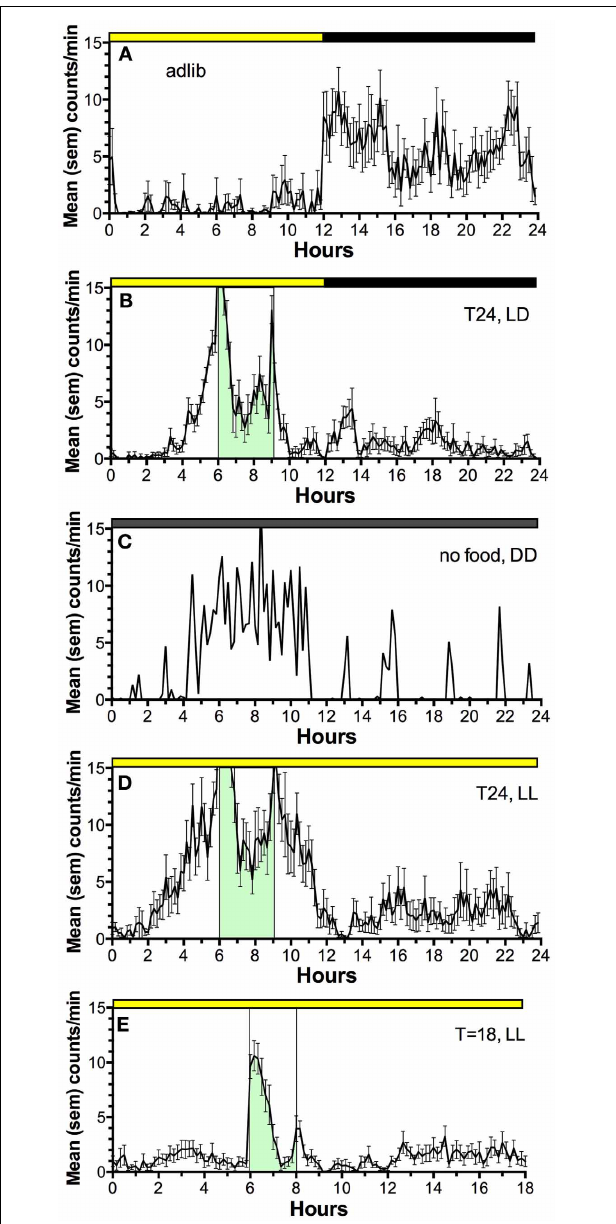
FIGURE 2 | Average waves illustrating the temporal distribution of spontaneous locomotor activity of a representative rat under the following feeding conditions. (A) ad-lib access to food (10 day average). (B) Food restricted to 3-h/day, beginning 6h after lights on, for 3 weeks (last 10 day average). (C) Day 2 of total food deprivation after 3 weeks of restricted daytime feeding. (D) Food restricted to 3-h/day for 3 weeks, after a month in constant light with food ad-lib , to eliminate the light-entrainable, free-running rhythm controlled by the SCN (a reversible SCN “lesion” procedure). (E) Food restricted to 2-h/day in constant light, delivered every 18h, illustrating failure of rats to anticipate a daily meal at regular but non-circadian intervals. Mealtime is denoted by green shading and vertical bars. Activity was measured by motion sensors, and plotted as average counts per minute, in 10min